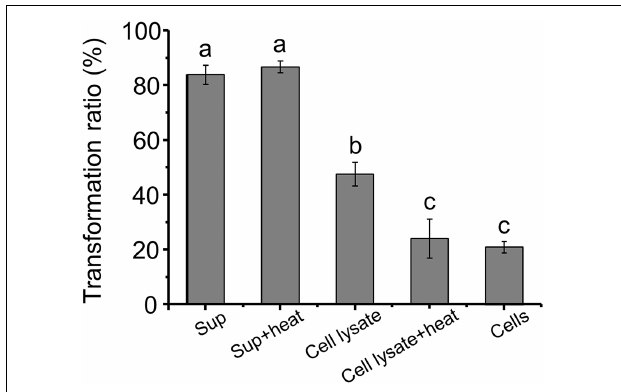
FIGURE 3 | Aflatoxin B 1 (AFB 1 ) transformation by the supernatant, cells and cell lysate of m29 at 37 ◦ C after 24 h of incubation. The initial concentration of AFB 1 was 0.5 ppm. Sup: supernatant; Sup + heat: supernatant treated at 121 ◦ C for 20 min; Cell lysate + heat: cell lysate treated at 121 ◦ C for 20 min. Values expressed as mean ± SD, and different letters represent significant difference according to Tukey’s LSD test ( p < 0.05).